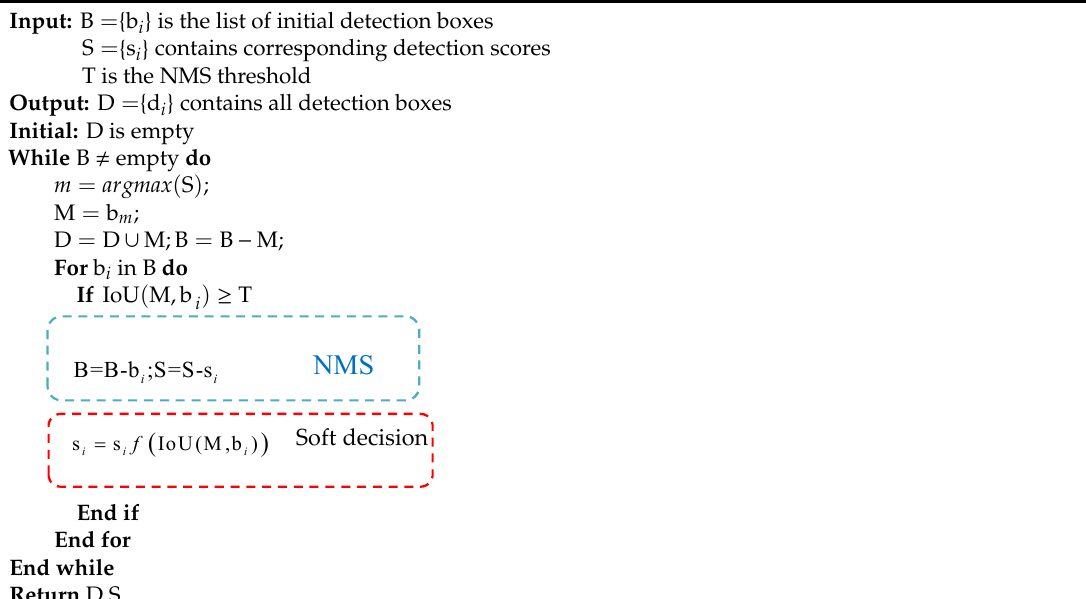
Table 1. The pseudocode of nonmaximum suppression (NMS) based on soft decision.